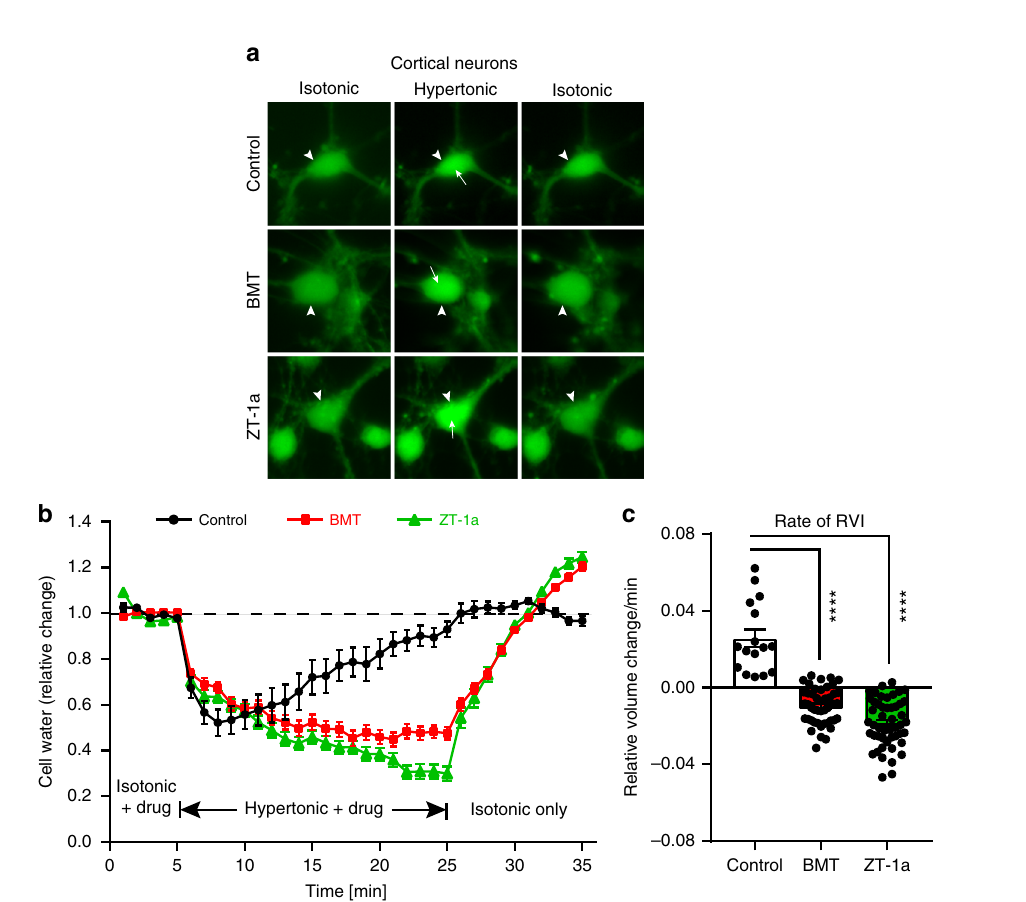
Fig. 5 Effects of ZT-1a on cell volume changes in mouse primary cortical neurons. a Representative images of calcein-AM-loaded mouse primary cortical neurons. Arrowheads mark cells of interest. Arrows illustrate regions of increased fl uorescence intensity in response to hyperosmotic stress. Cells were exposed to isotonic HEPES-MEM (310 mOsm, 5 min, ± drug), hypertonic HEPES-MEM (370 mOsm, 20 min, ± drug), and isotonic HEPES-MEM (10 min, no drug) in the absence or presence of SPAK inhibitor ZT-1a (3 μ M) or the potent NKCC1 inhibitor bumetanide (BMT, 10 μ M). b Relative cell water content changes as a function of time during indicated bath conditions. c Summary data of the rate of regulatory volume increase (RVI). The rate was calculated by determining the slope between minutes 8 and 25. Data are means ± SEM, n = 49 cells for control, 46 cells for BMT, and 49 cells for ZT-1a collected from three independent experiments. **** p < 0.0001 versus control, one-way